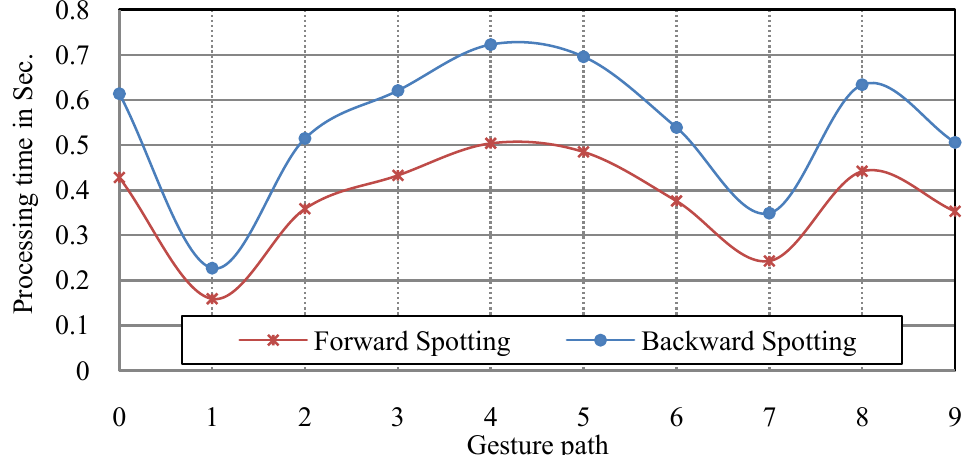
Figure 14. Average segmentation times for forward and backward spotting methods.